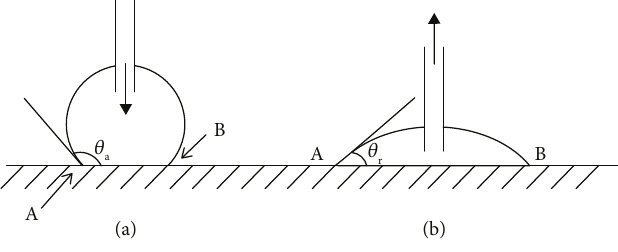
Figure 5: The advancing angle and receding angle. Table 1: Advancing and receding contact angle (viscosity ratio). Wetting